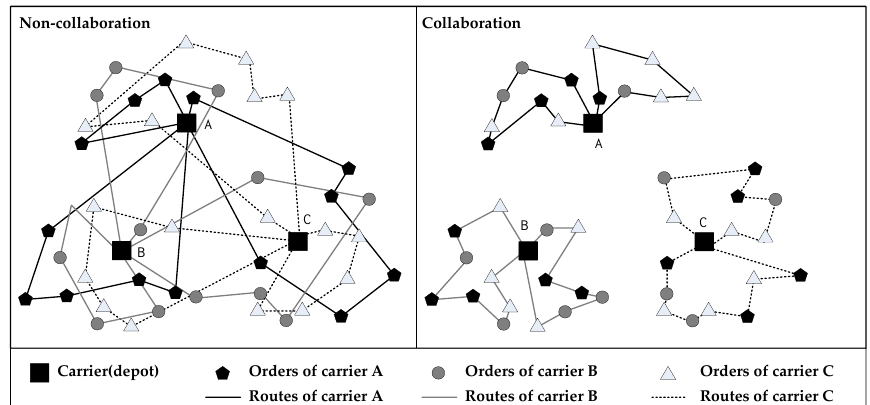
Figure 2. An example of the CMCVRP with three carriers.